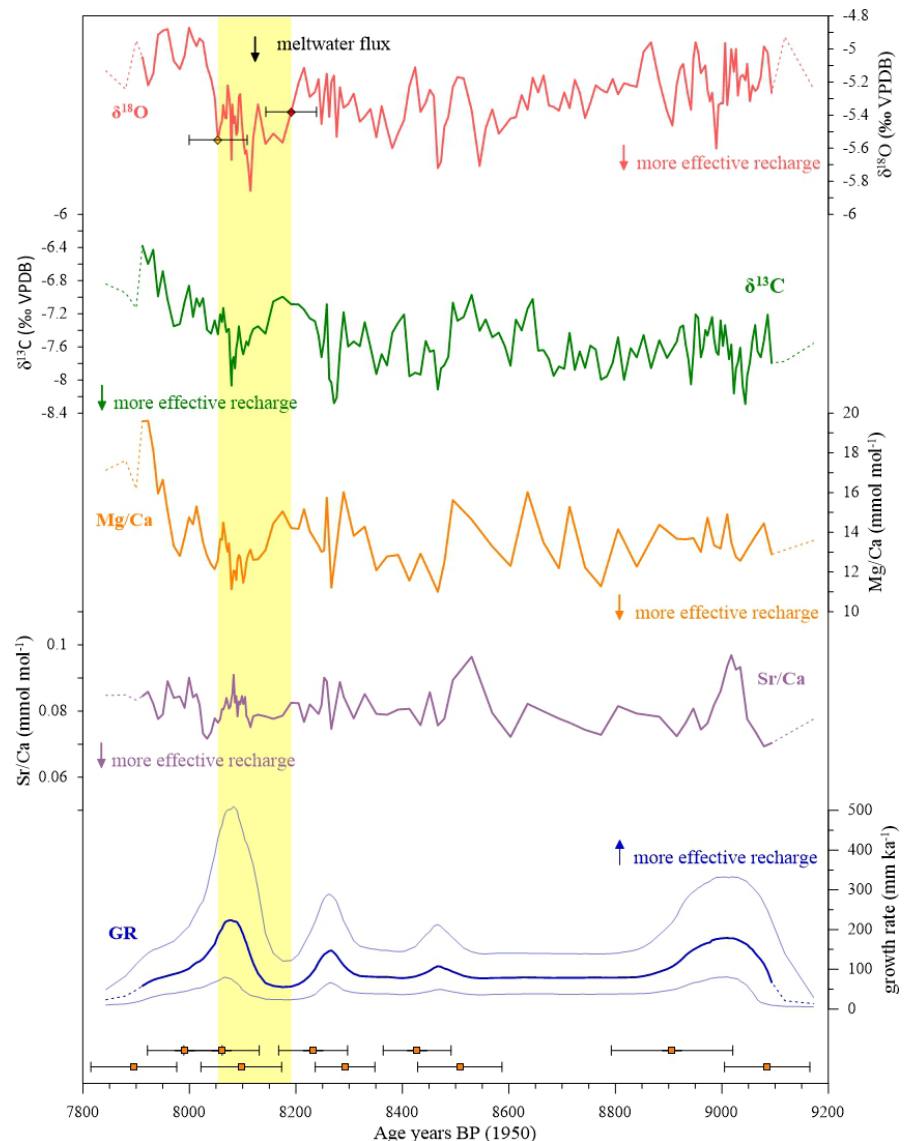
Figure 5. SIR-14 proxy time series from 7.8–9.2ka. From top: δ 18 O, δ 13 C, Mg / Ca, Sr / Ca, growth rate (1 σ uncertainties) and U–Th dates (2 σ uncertainties). The δ 18 O displays a negative excursion through the event, and its duration is shown by yellow shading. During this interval the δ 13 C and Mg / Ca decrease, but this excursion does not stand out as a clear Holocene anomaly but rather represents one of several excursions of similar magnitude that occur over the preceding ∼ 1000 years. The Sr / Ca does not show any variation of significance. Across the 8.2ka event, there is a spike in the growth rate where it reaches a maximum of ∼ 220mmkyr − 1 . The change in growth rate stands out against the entire record, but it is associated with large uncertainties (reflecting the age-model